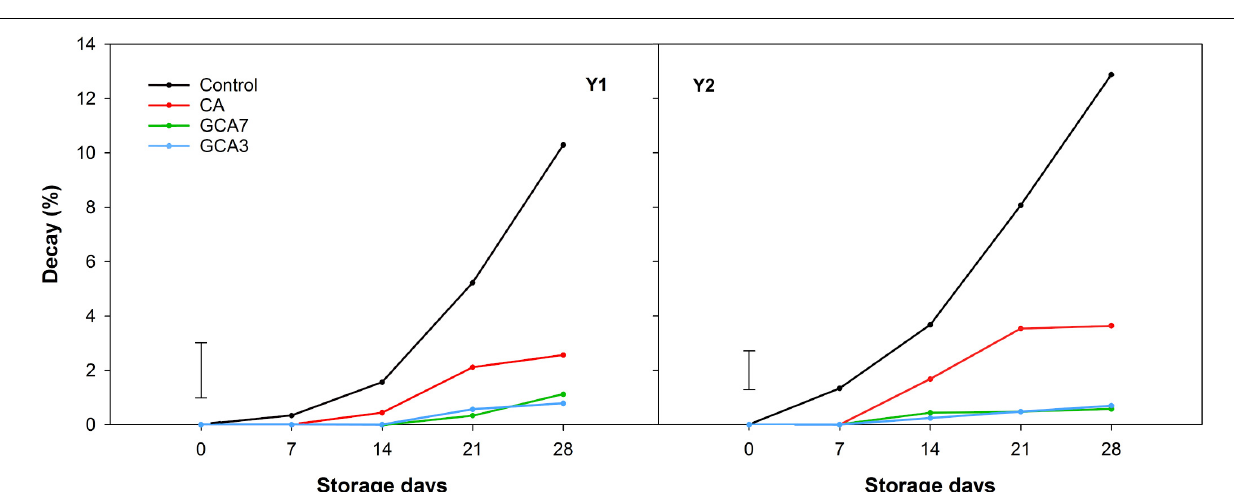
FIGURE 3 | Decay expressed as percentage (%) of “Duke” blueberry fruit subjected to controlled atmosphere (CA) applications throughout 28 days of storage at 0 ◦ C and 90–95 RH%; air [control]; standard CA (10 kPa CO 2 + 5 kPa O 2 ); graduated CA 7 (GCA7; 7 days to achieve standard CA values); and GCA3 (3 days to achieve standard CA values). Two consecutive seasons are considered 2017 (year 1; Y1) and 2018 (Y2). Data represents means ( n = 300). Least Significant Differences (LSD) are included as LSD treatment ∗ time = 1.0145 for Y1 and LSD treatment ∗ time = 0.713 for